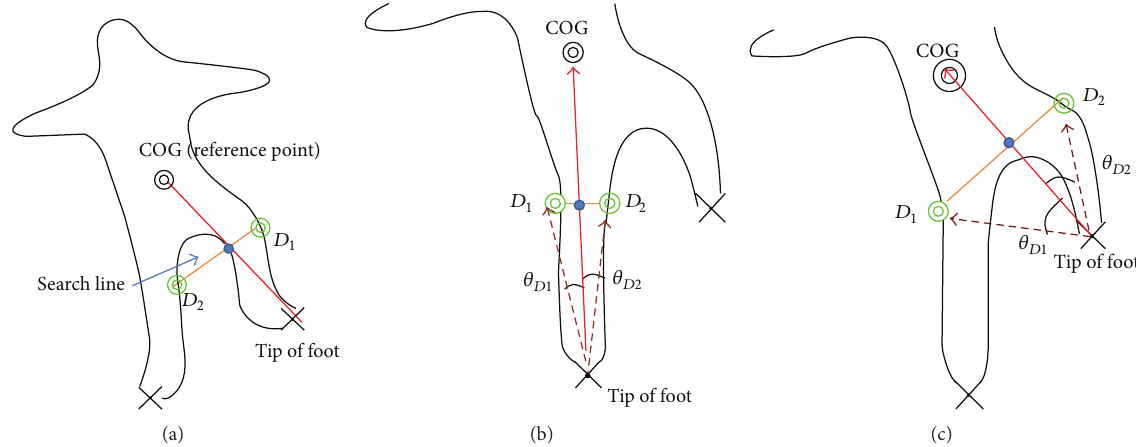
Figure 7: (a) Locations of the two knee candidates on the contour. (b) and (c) The candidate points 𝐷 1 and 𝐷 2 and the included angles 𝜃 𝐷 and 𝜃 𝐷 for locating the knees in the 2